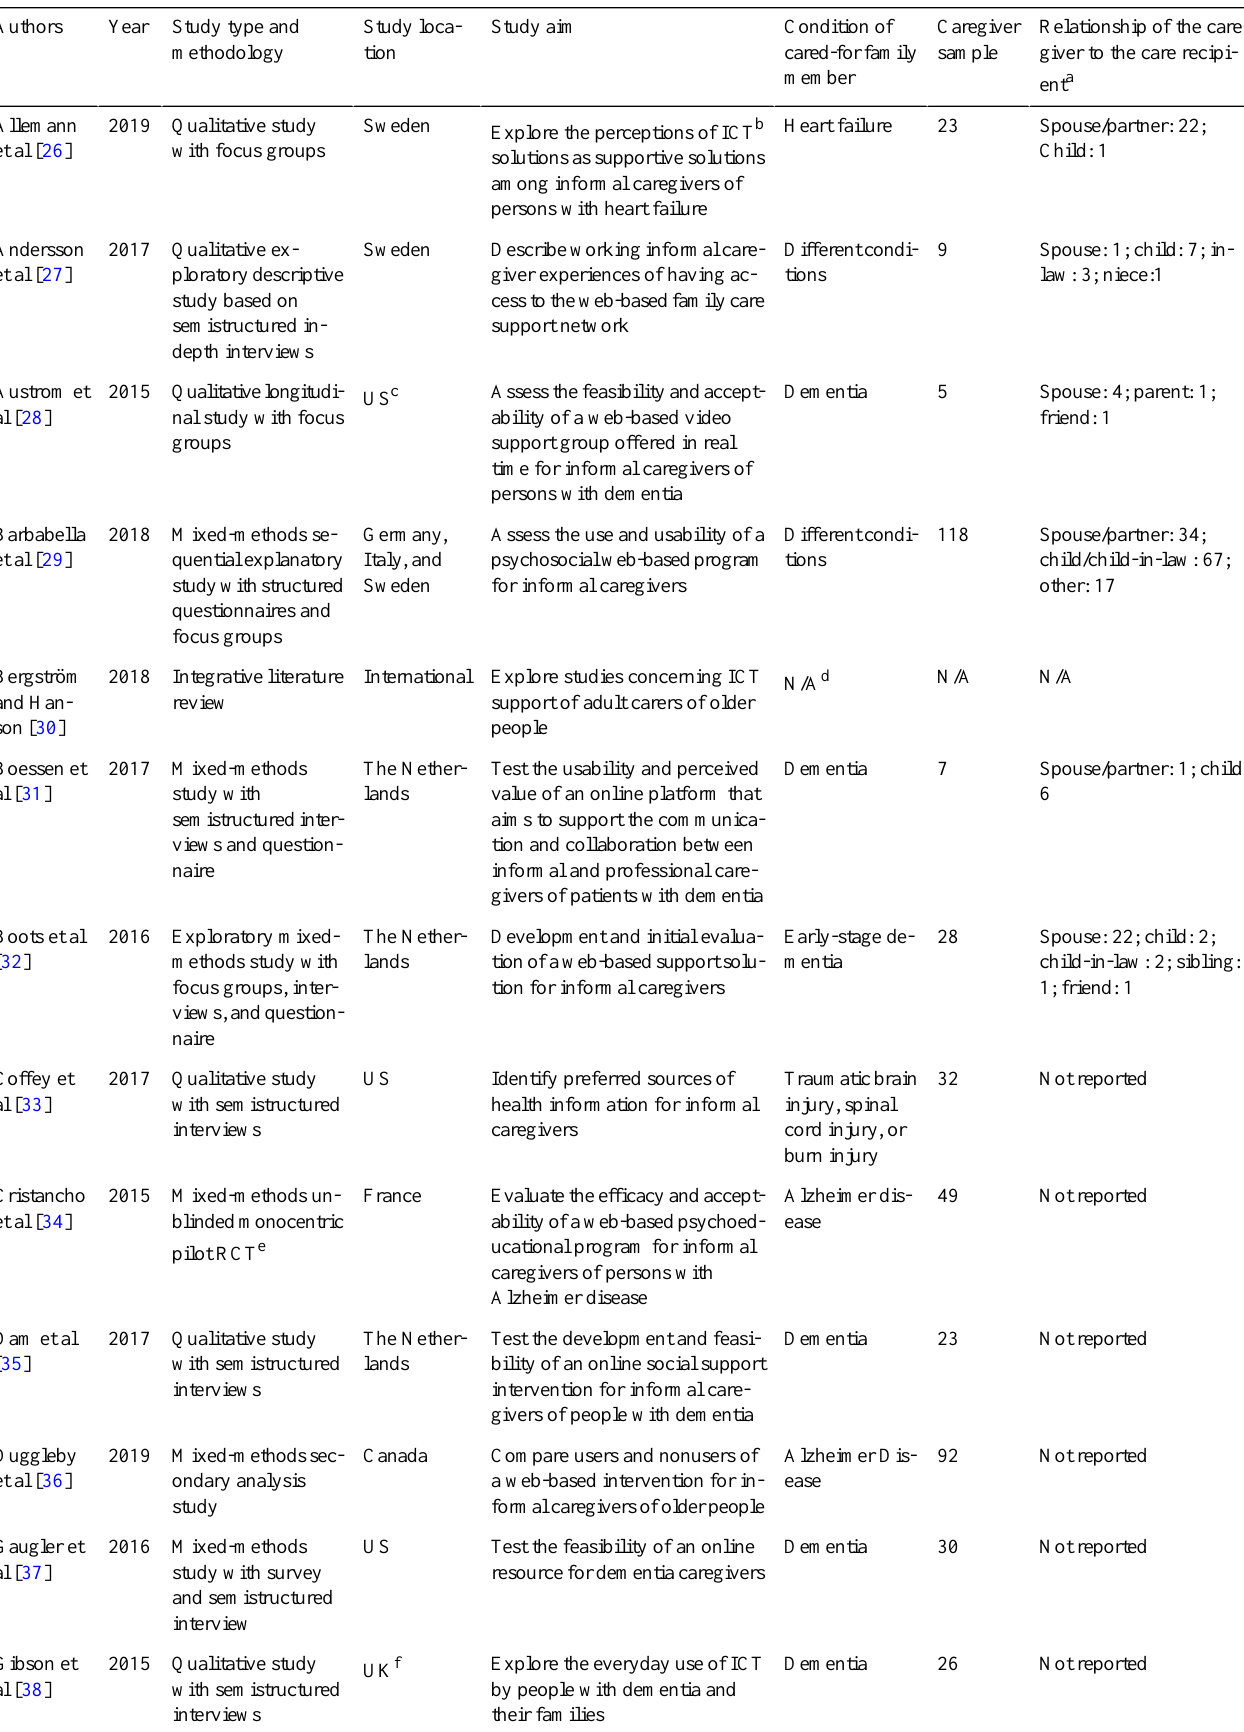
Table 2. Summary of the information for the included publications.